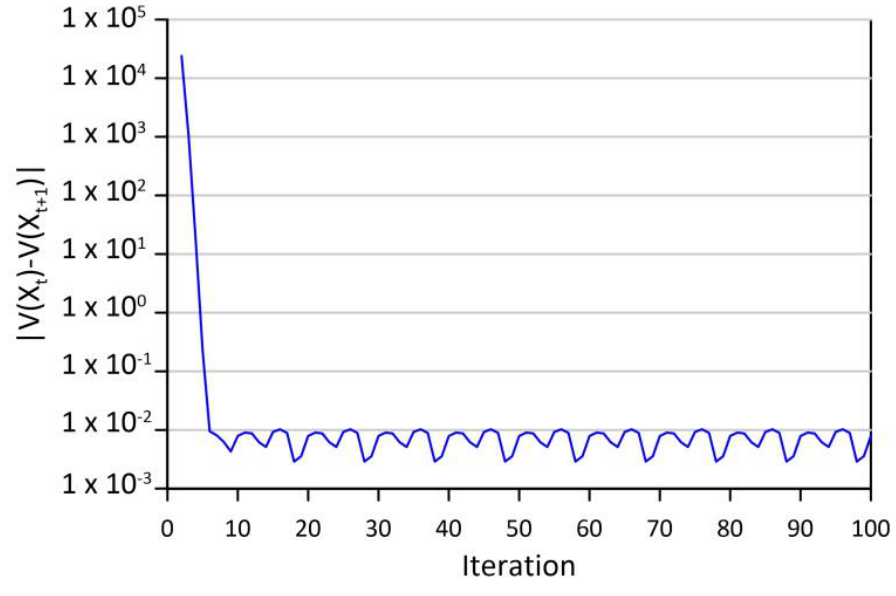
Figure 6. Trial 1: Iteration cycle. Trial 2